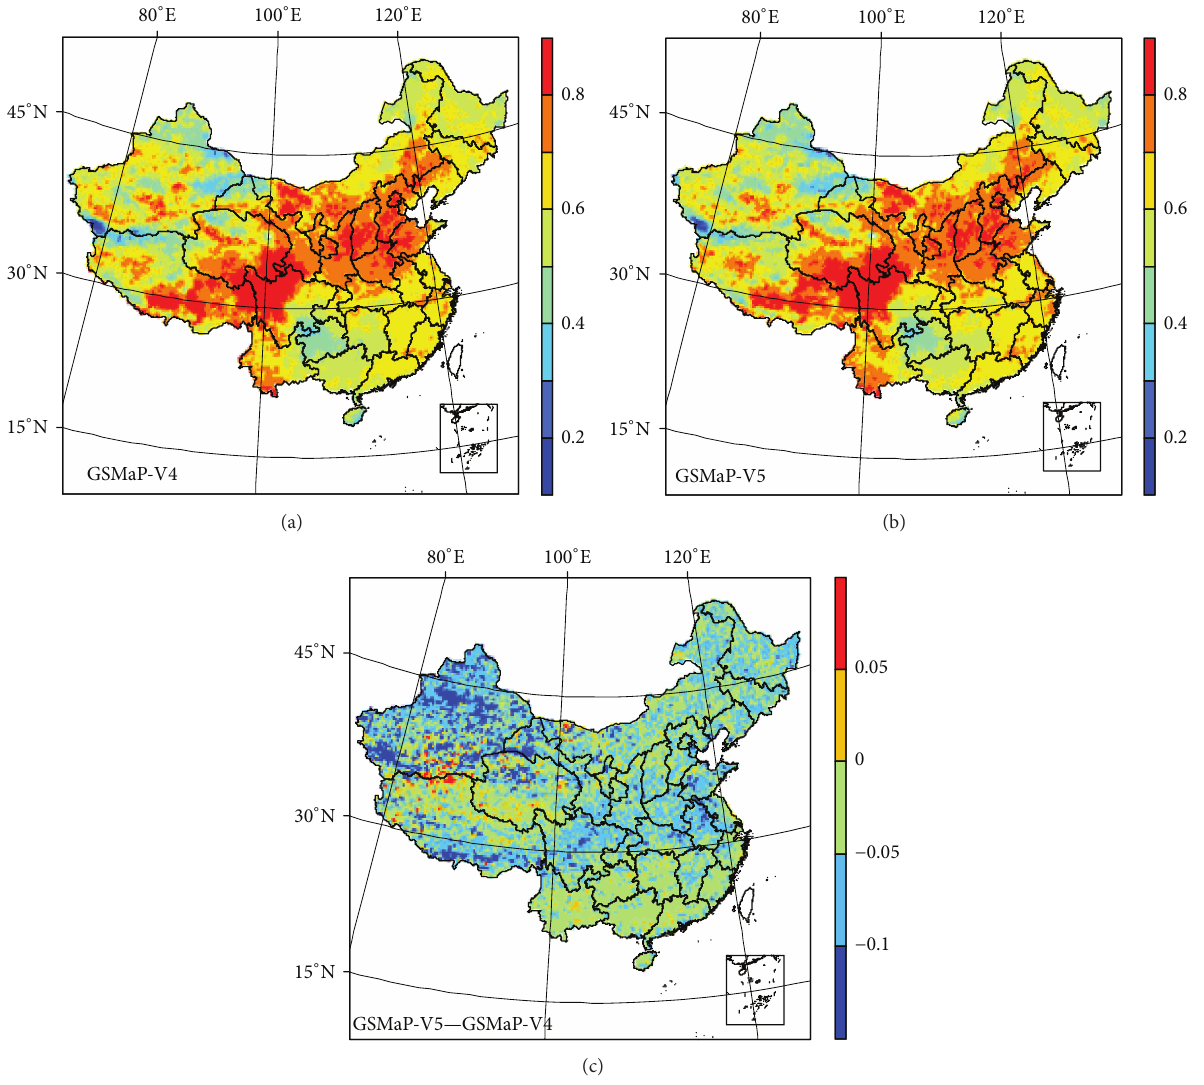
Figure 7: Distribution of probability of detection for GSMaP products over the Chinese Mainland from 2003 to 2006. (a) GSMaP-V4, (b) GSMaP-V5, and (c) difference between GSMaP-V4 and